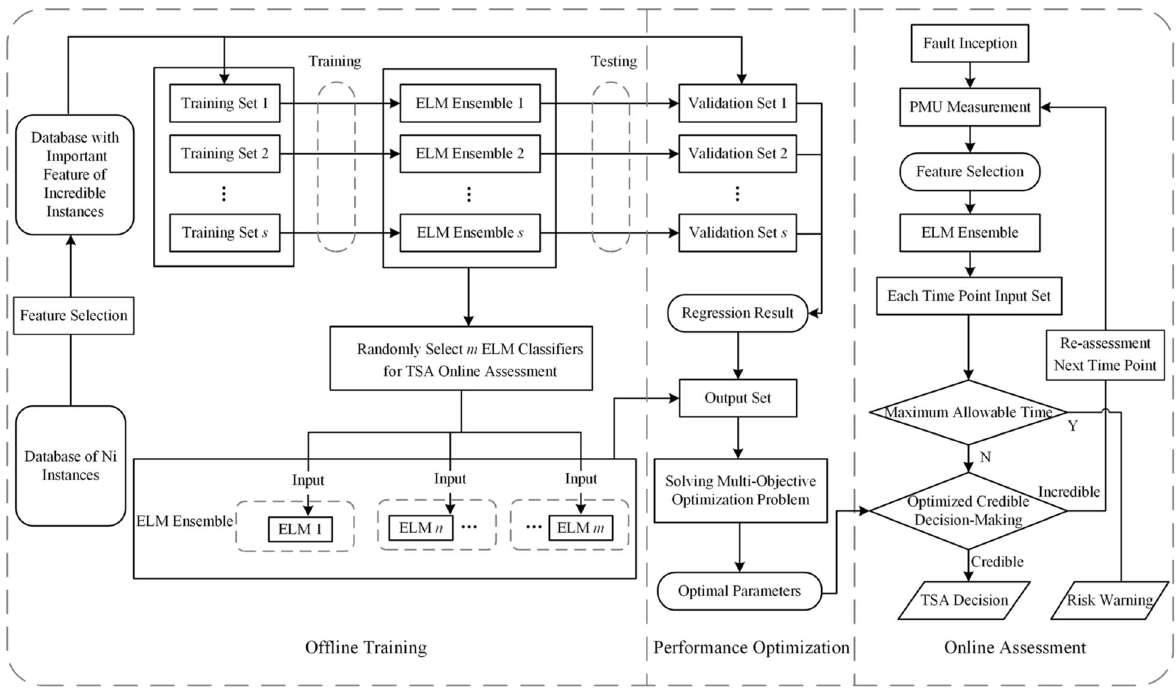
Fig. 4 The Optimal Self-Adaptive TSA